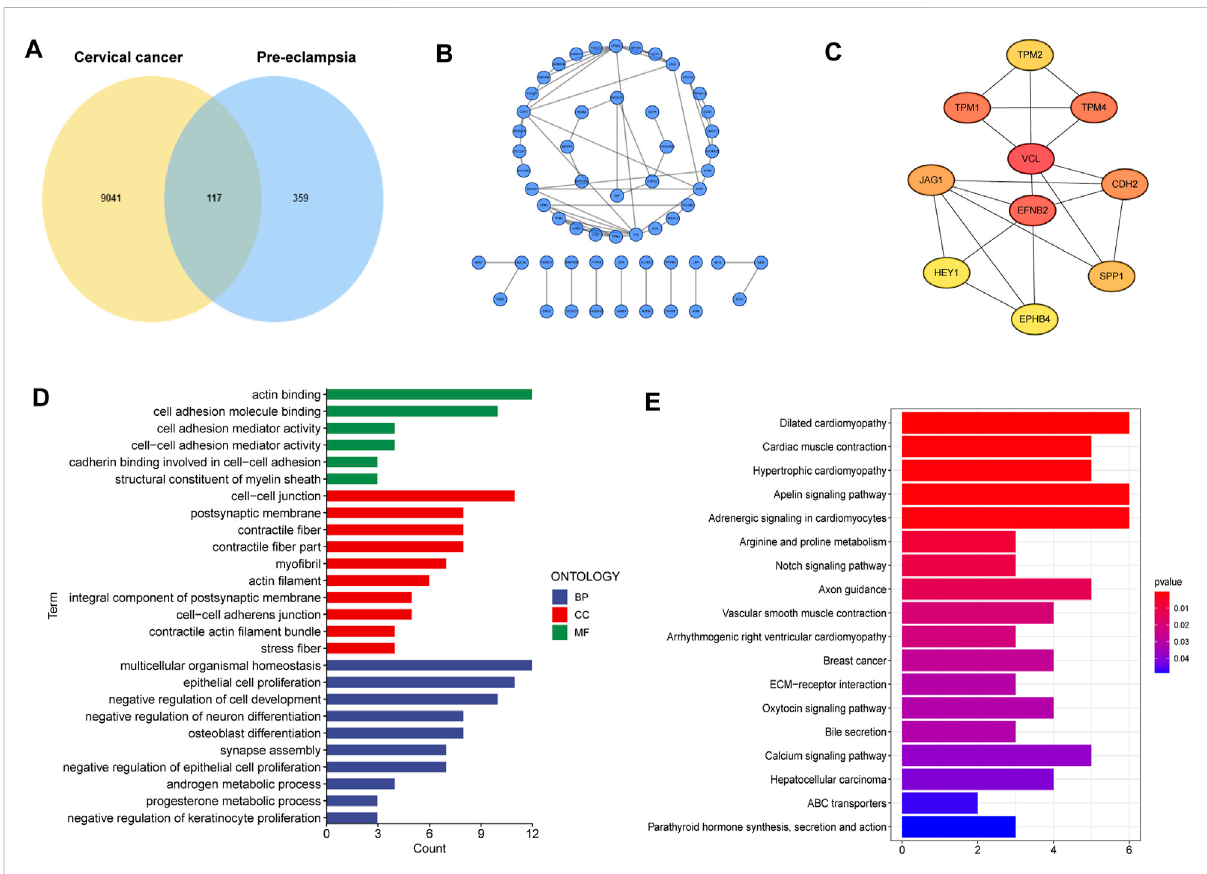
FIGURE 2 CharacterizationofthesharedgenesinPEandCC. (A) TheVennplotofoverlappedgenes. (B) ThePPInetworkoftheoverlappedgenes. (C) The top 10 hub genes of the PPI network. (D) GO function enrichment analysis. (E) KEGG enrichment